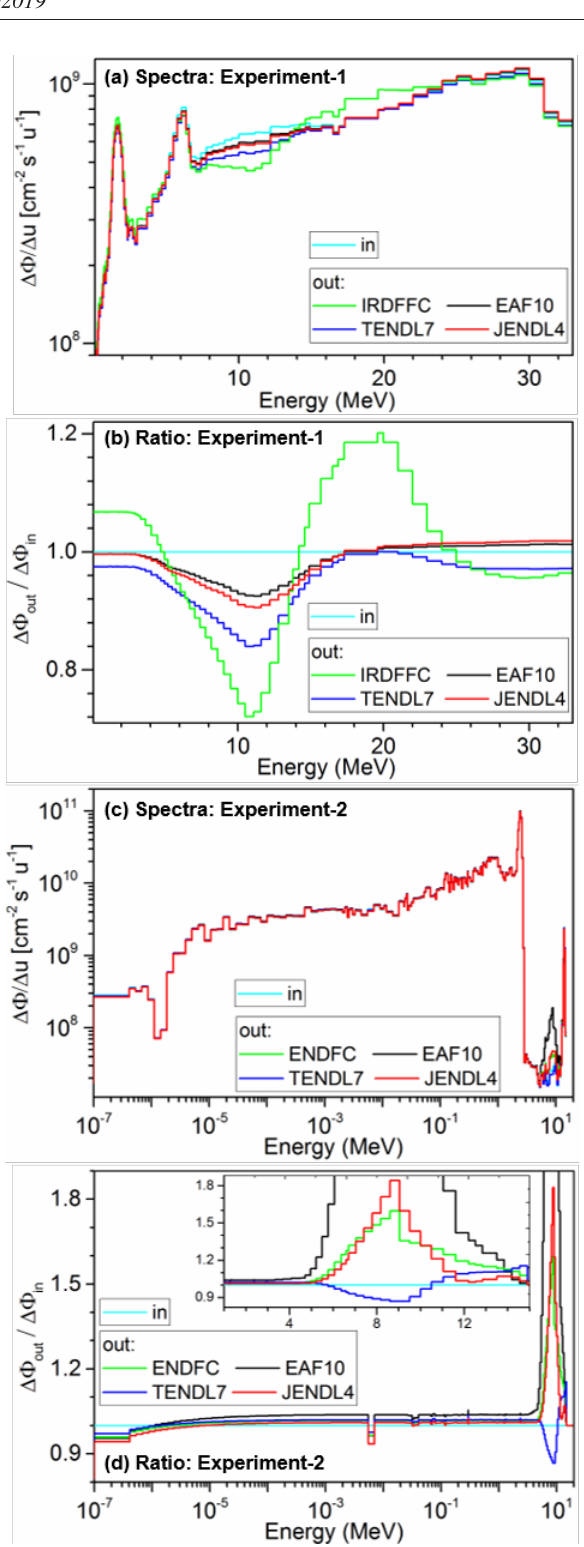
Fig. 1. Comparison of unfolded spectra for the two experiments. (a) and (b) show results from Experiment-1, while (c) and (d) from Experiment-2. (a) shows lethargy-plots for Experiment-1, where input (in) spectrum and output (out) spectra with four different response-functions are plotted versus energy. (b) shows the data of (a) in ratio form, where all group-wise fluxes have been divided by the input group-flux. Similarly, (c) shows lethargy-plots for input and output spectra from Experiment-2, and (d) the corresponding ratio plots w.r.t. energy. In the inset of (d) an expanded version of the sensitive region is